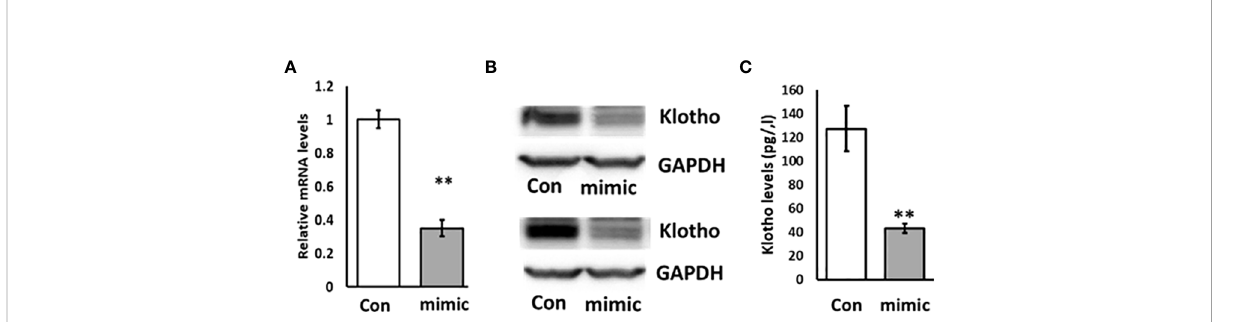
FIGURE 3 Overexpression of miR-192 inhibits the expression of KL in HK2 cells. miR-192 mimic or scrambled miRNA were transfected into HK2 cells for 72 hours and mRNA (A) , protein (B) and soluble KL in the media (C) were detected by real time PCR, immunoblotting and ELISA. **p <